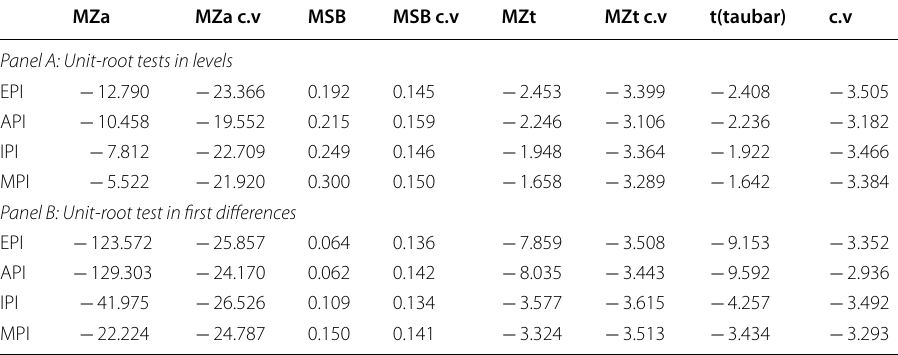
c.v. represents critical value